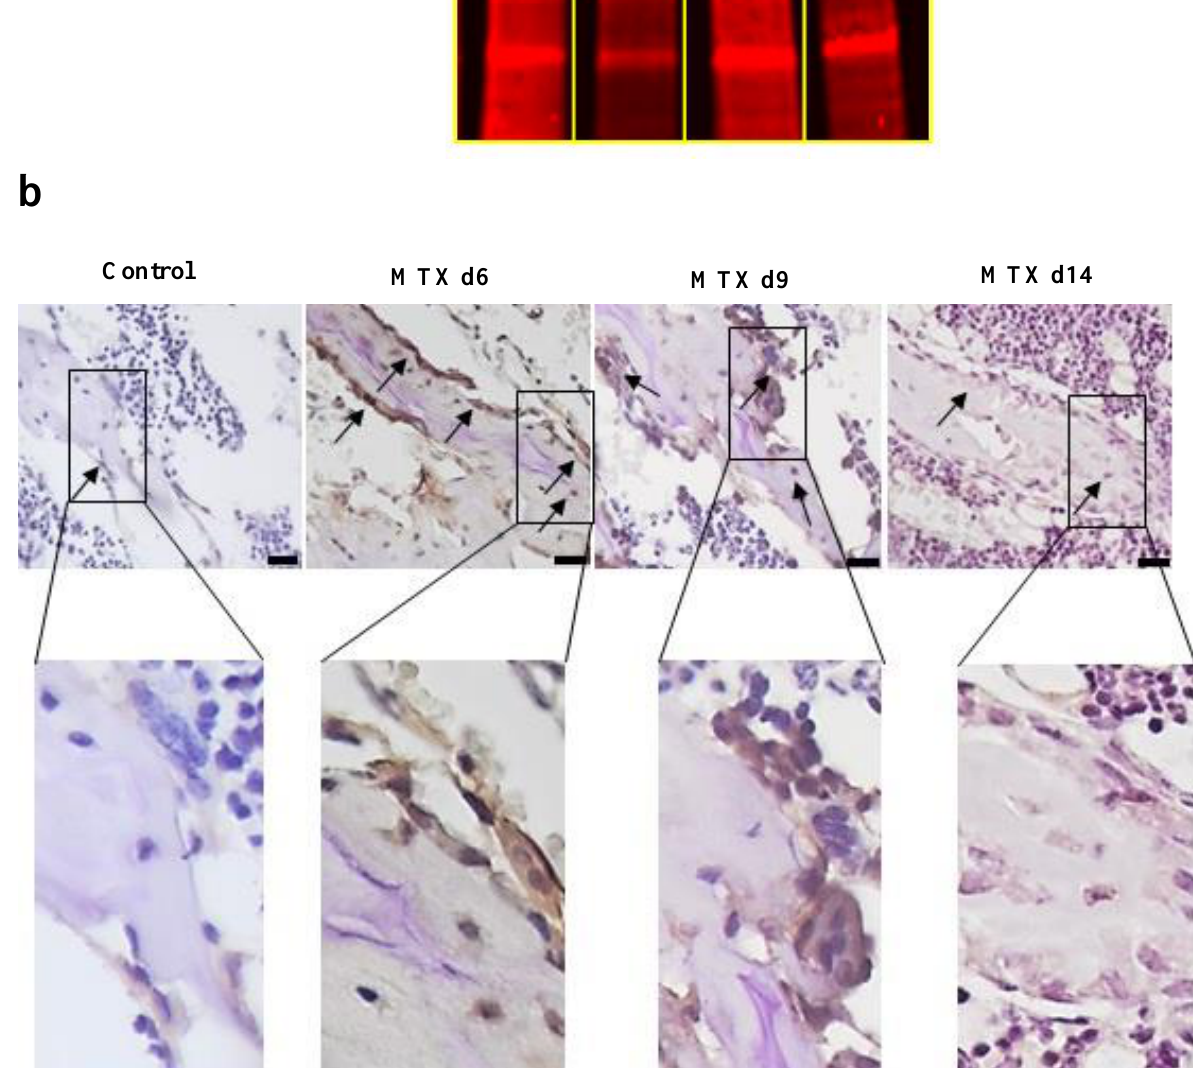
Figure 2. MTX treatment increases NICD2 protein levels following MTX treatment as assessed by Western blot and immunohistochemistry staining. ( a ) Metaphyseal bone NICD2 protein expression at different time points as assessed by Western blot with total protein being used as an internal loading control; ( b ) Immunohistochemistry of bone samples at different time points, with day 6 and day 9 MTX samples illustrating strong positivity for NICD2 protein in lining osteoblasts and osteocytes as indicated by black arrows, and control and day 14 MTX bone samples having faint staining of NICD2. Images were taken from lower region of the metaphysis (scale bar is 20 µm). 3.4. Notch2 Blockade Alleviated MTX Adverse Effects in Metaphysis Bone Volume and Struc- ture Next, to confirm the roles of Notch2 signalling in MTX bone damage, a neutralising anti-Notch2 antibody or a control IgG was administered to rats during MTX treatment. Micro-CT morphological analyses of tibial metaphysis trabecular bone volume and struc- ture revealed obvious changes in the trabecular bone following MTX treatment (Figure 3a,b). While there was a significant reduction in ratio of trabecular bone volume per tissue volume (BV/TV%) following MTX + control IgG treatment ( p < 0.05 vs. control), this re- duction was remarkably attenuated in MTX + anti-Notch2 treatment group ( p < 0.001 vs. MTX+control IgG) (Figure 3c). In addition, while MTX treatment showed a trend of re- ducing the trabecular number when compared to the normal control, blocking Notch2 along with MTX treatment remarkably attenuated the trabecular number reduction ( p < 0.05 vs. MTX + control IgG) (Figure 3d). Furthermore, while trabecular thickness remained unchanged among all groups (Figure 3e), trabecular separation was increased following MTX treatment ( p < 0.05 vs. controls), which was alleviated following MTX + anti-Notch2 treatment ( p < 0.05 vs. MTX + control IgG) (Figure 3f). Consistent with micro-CT analyses, histomorphometry assessment on H&E-stained bone sections obtained similar results on the treatment effects on metaphysis trabecular bone volume and structure (data not shown).